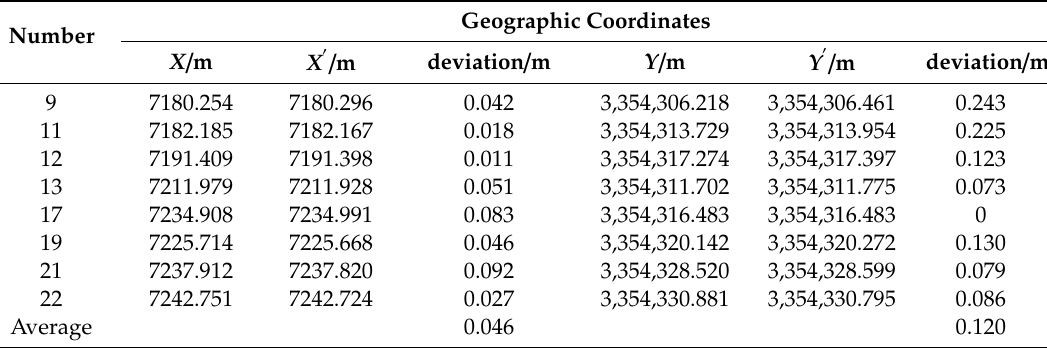
Table 7. Analysis of automatic registration